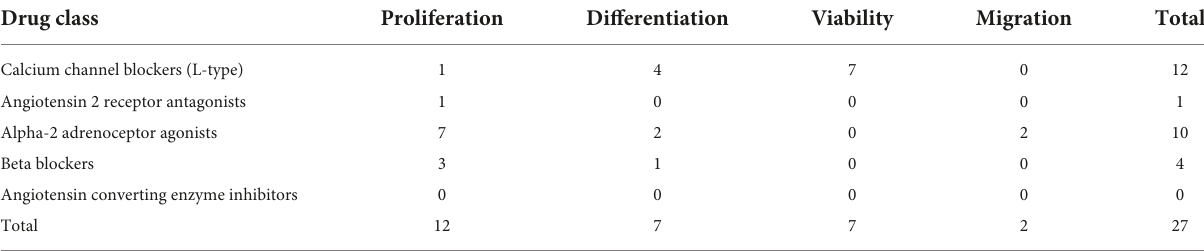
TABLE 1 Overview of experiments investigating effects of antihypertensive drugs on neural stem cell (NSC) characteristics. Drug class Proliferation Differentiation Viability Migration Calcium channel blockers